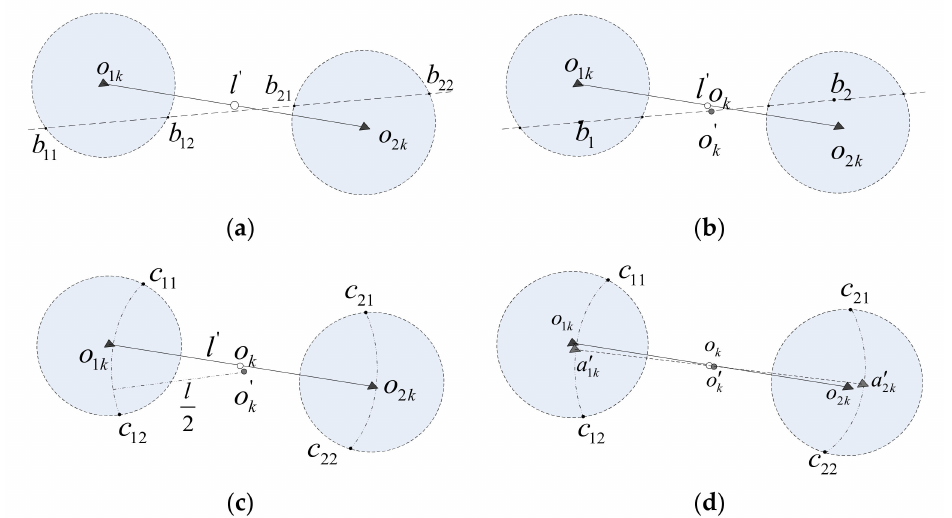
Figure 4. Scheme for joint positioning when both reader antennas detect enough tags (three at least): ( a ) Acquire four intersections, ( b ) Obtain a line b 1 b 2 , ( c ) Estimate the vehicle position o (cid:48) Estimate the footprint